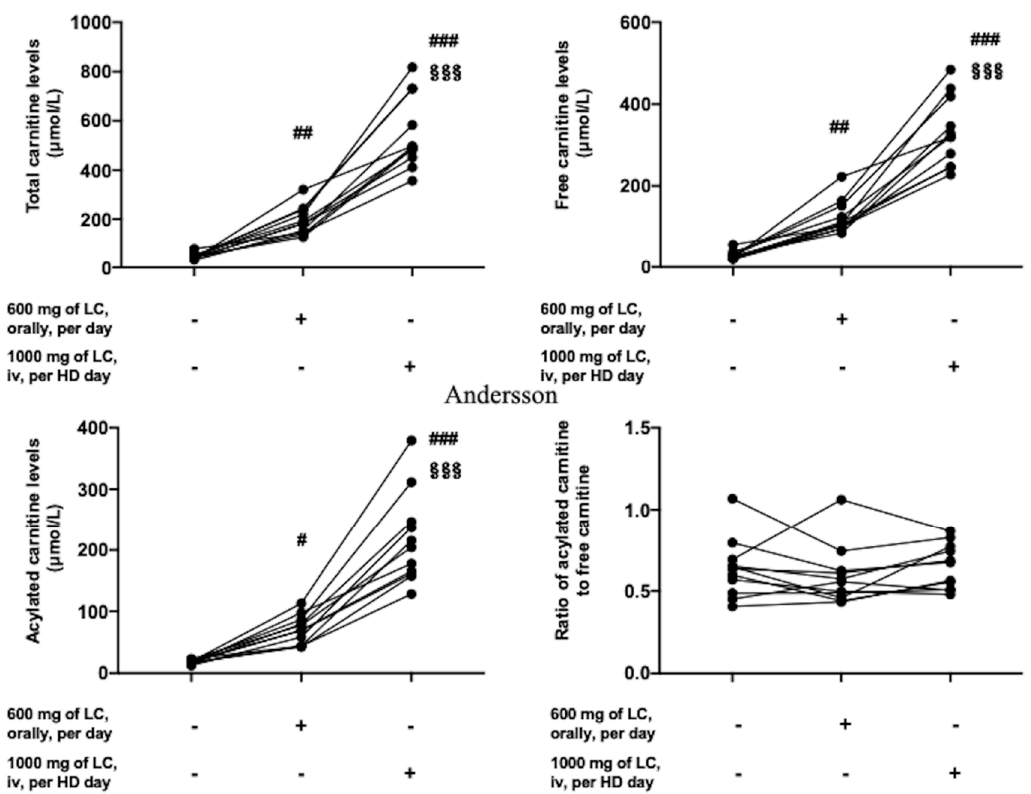
Figure 1. Temporal profile of carnitine kinetics after L -carnitine treatment. Serum total, free, and acylated carnitine concentrations were measured, and the ratios of acylated carnitine to free carnitine were calculated before L -carnitine treatment, at 6 months after 600 mg of L -carnitine treatment orally a day, and at 6 months after 1000 mg of L -carnitine treatment per hemodialysis day. # p < 0.05, ## p < 0.01, ### p < 0.001 vs. at baseline; §§§ p < 0.001, vs. at 6 months after 600 mg of L -carnitine treatment orally. LC = L -carnitine; HD = hemodialysis.